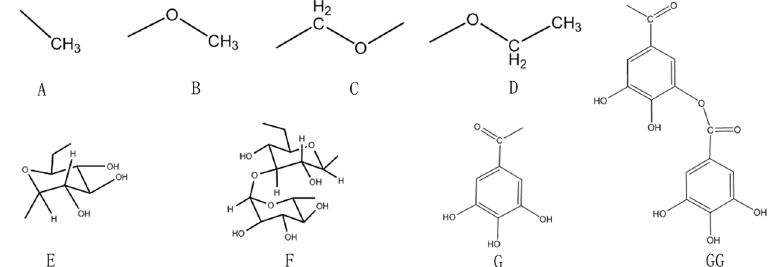
Figure 3. Turkish galls: chemical composition of common substituents.